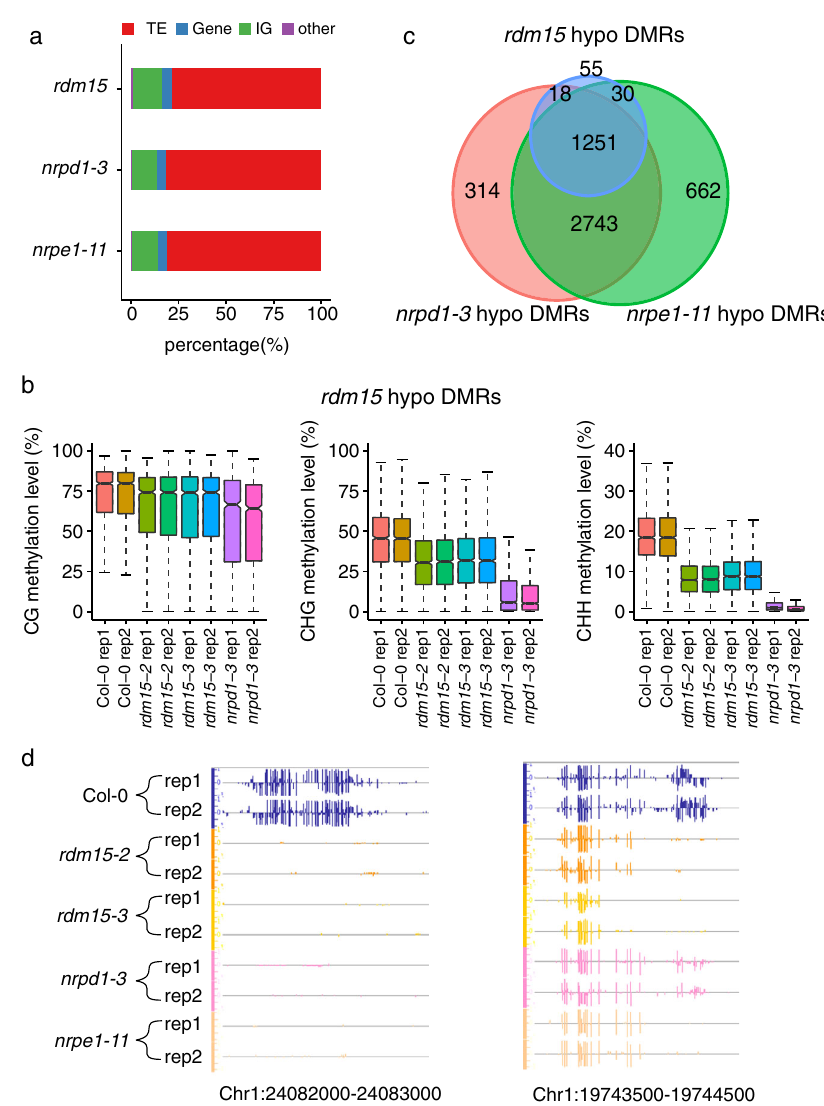
Fig. 2 RDM15 is required for RdDM-dependent DNA methylation. a Compositions of DMRs among TEs, genes, and intergenic regions (IGs). DMRs (relative to the WT) were identi fi ed in rdm15 , nrpd1-3 , and nrpe1-11 . b Box plots showing CG, CHG, and CHH methylation levels of rdm15 DMRs in Col-0, rdm15-2 , rdm15-3 , and nrpd1-3 . Data from two replicates are shown. c Venn diagram showing the numbers of hypomethylated DMRs that overlapped between rdm15 , nrpd1-3 , and nrpe1-11 . d The Integrative Genome Browser (IGB) display of whole-genome bisul fi te sequencing (WGBS) data is shown for several representative rdm15 DMRs in Col-0, rdm15-2 , rdm15-3 , and nrpd1-3 . Vertical bars on each track indicate DNA methylation levels. The coordinates of DMRs are indicated below the snapshots. Two replicates are shown for each